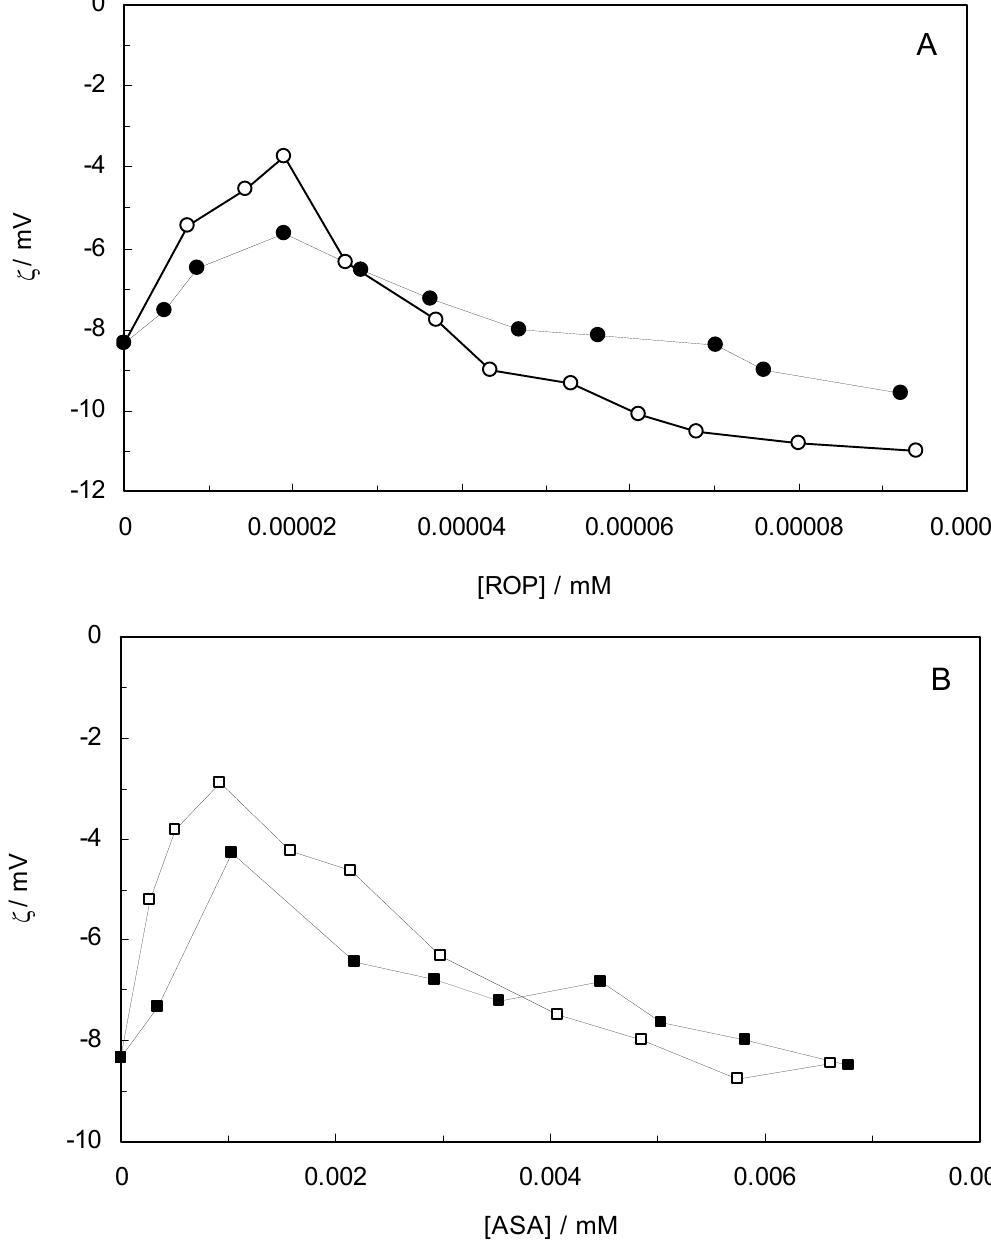
Figure 10. ( A ) Zeta-potential spectra at varying concentrations of ROP in the absence and presence of ASA. [hTf] = 3.8 × 10 − 3 mM, [ASA] = 4.62 × 10 − 3 mM, for the ternary system; ( B ) Zeta-potential spectra at various concentrations of ASA in the absence and presence of ROP. [hTf] = 3.8 × 10 − 3 mM, [ROP] = 1.33 × 10 − 5 mM, for the ternary system. pH 7.4 and T = 298